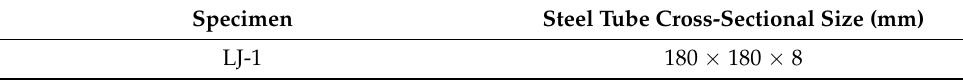
Table 1. Parameters of the LJ-1 specimen.